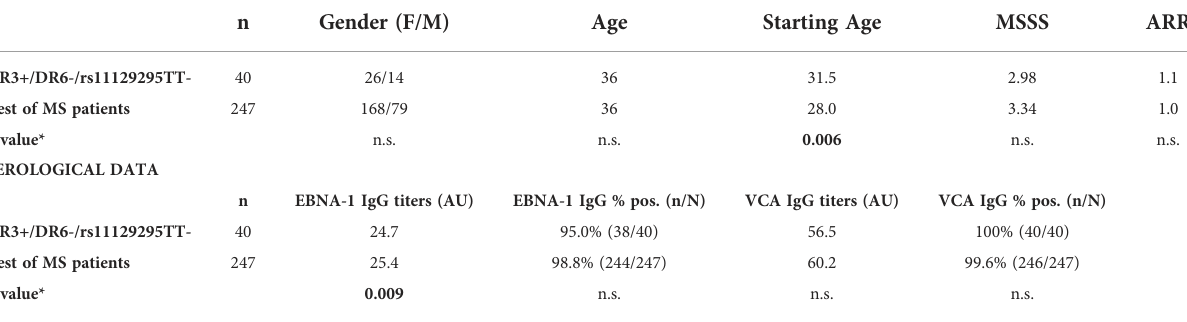
TABLE 6 Epidemiological, clinical and serological data of MS patients before DMT onset according to the genetic background associated with EBNA-1 IgG